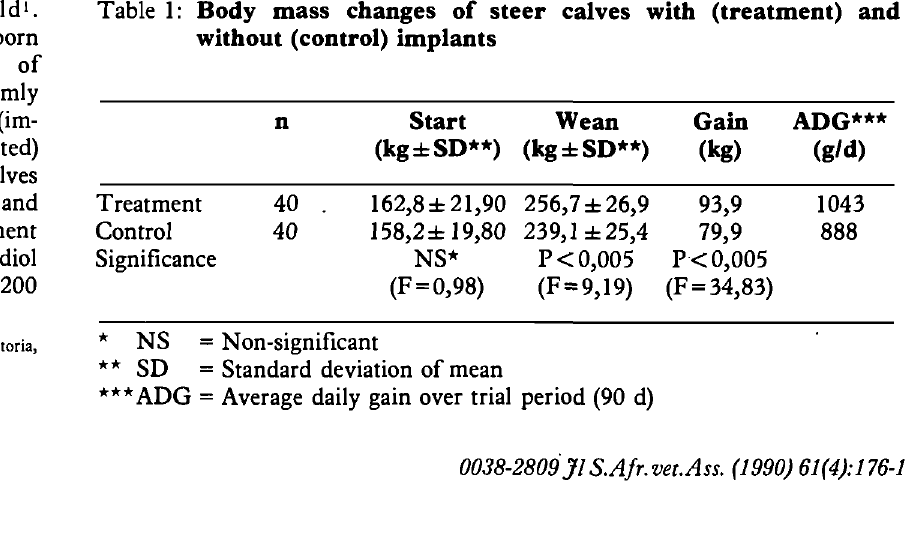
Table 1: Body mass changes of steer calves with (treatment) and without (control)